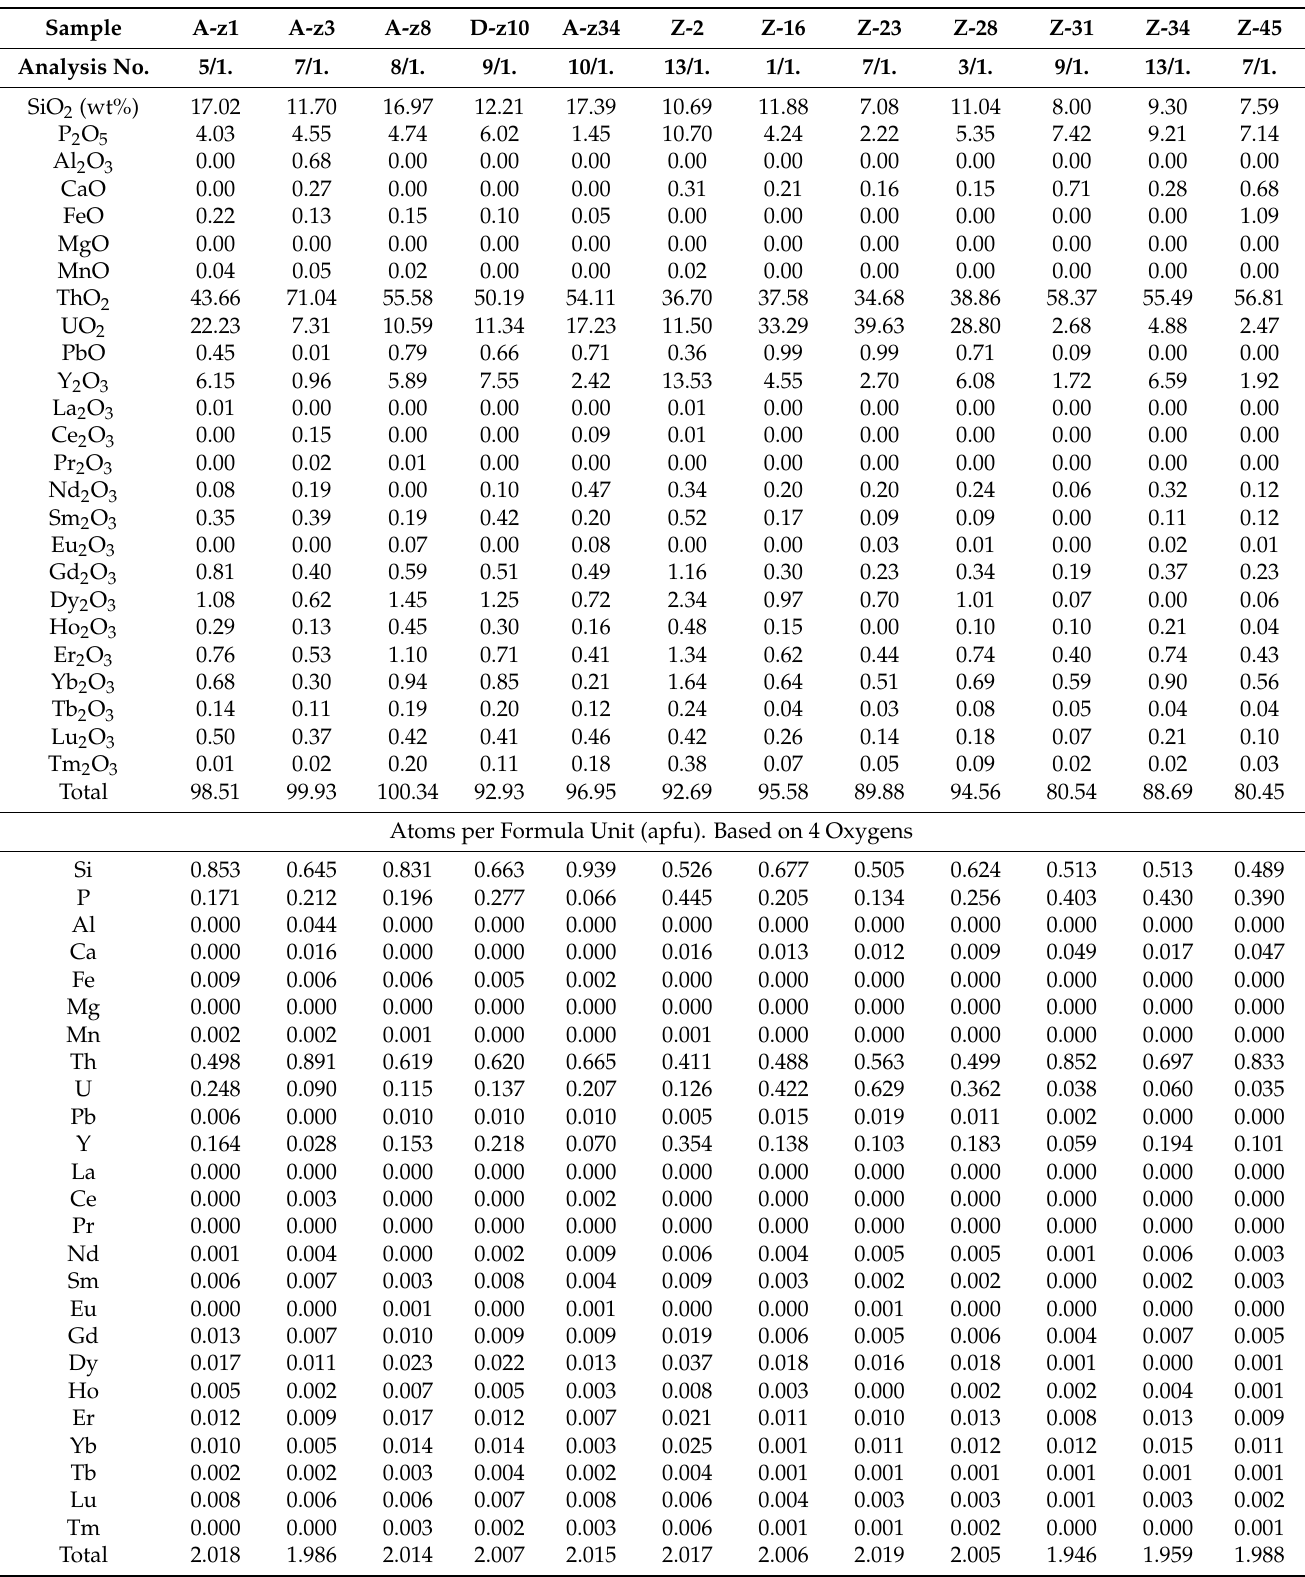
Table 5. Chemical composition of thorite-uranothorite. EMP